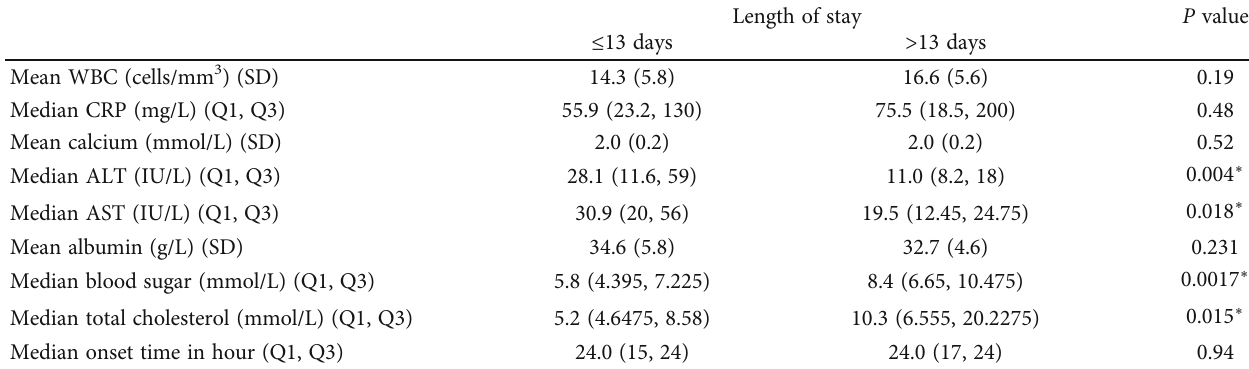
Table 4: Association between length of stay at hospital and biochemical